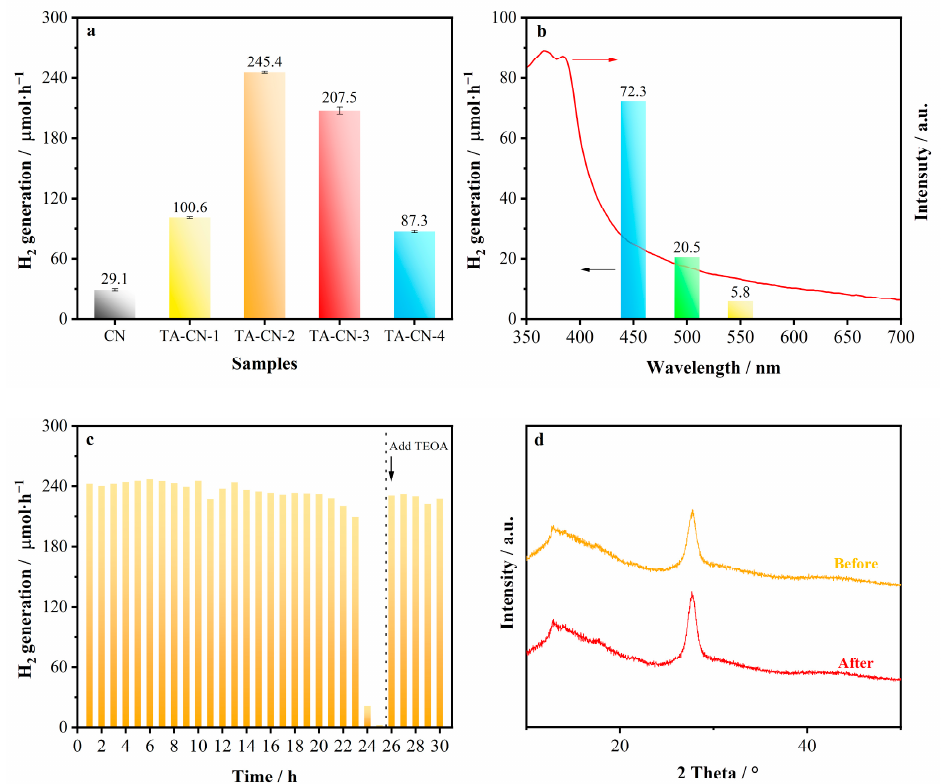
Figure 11. ( a ) Photocatalytic H 2 evolution rates of CN and TA-CN-x (50 mg catalyst); ( b ) absorption spectrum and wavelength-dependent photocatalytic H 2 evolution rates; ( c ) photocatalytic H 2 evolution stability test in 30 h and ( d ) XRD patterns before and after stability test of TA-CN-2. Based on the experimental and theoretical calculation results, the possible photocatalytic H 2 evolution reaction mechanism over TA-CN is proposed and shown in Figure 12. Under visible light irradiation, photogenerated charges are produced and separated in the TA-CN skeleton. Then, the photogenerated electrons migrate to the thiophene-amide struc- ture due to the induction and delocalization effects. Then, the photogenerated electrons transfer to the Pt particles for the reduction in proton to H 2 , while the photogenerated holes are consumed by